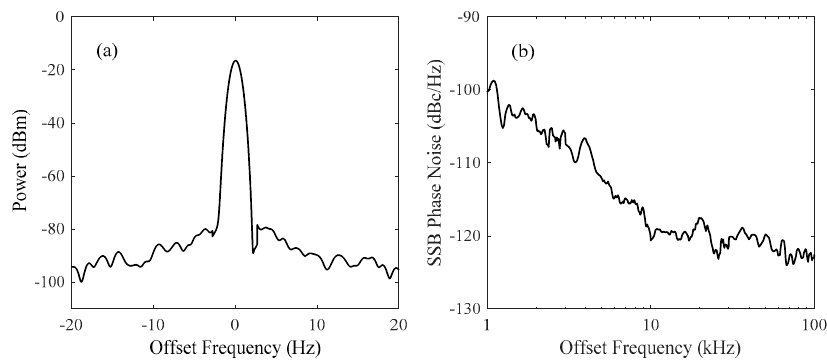
Figure 5. Experimentally measured ( a ) detailed power spectrum and ( b ) SSB phase noise centered at 2.8 GHz under a resolution bandwidth of 1 Hz.